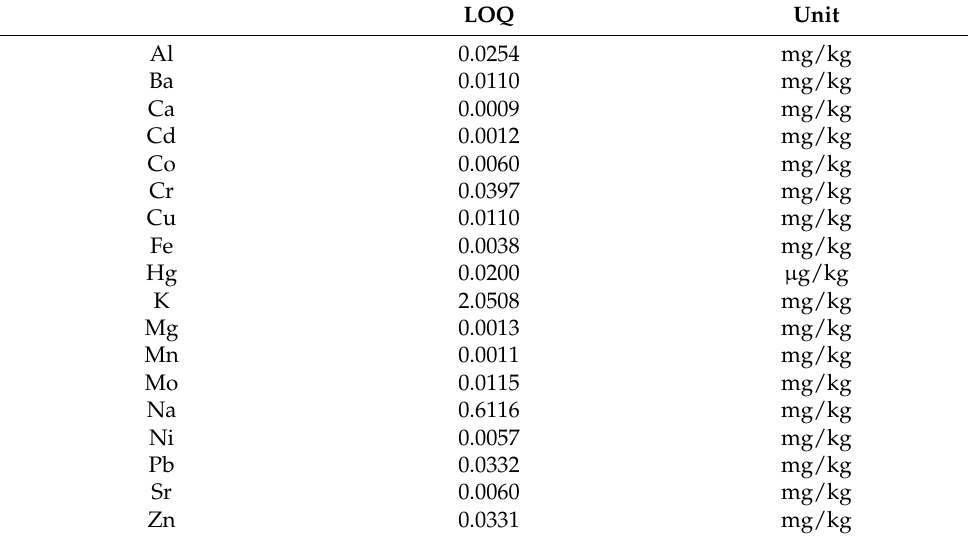
Table 1. The LOQs for each monitored chemical